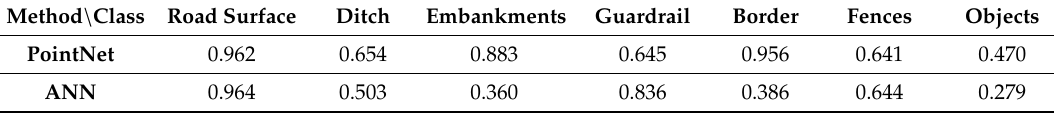
Table 3. Accuracy comparison between the segmentation with PointNet and